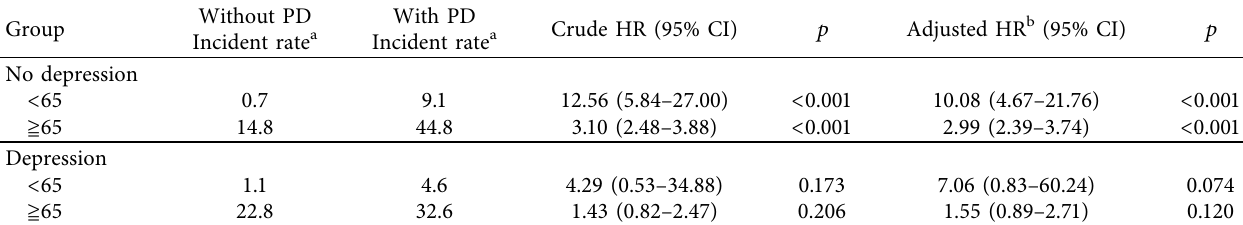
Table 4: Incident rate and hazard ratio for dementia with PD in depression subgroups with cutoff age at 65.